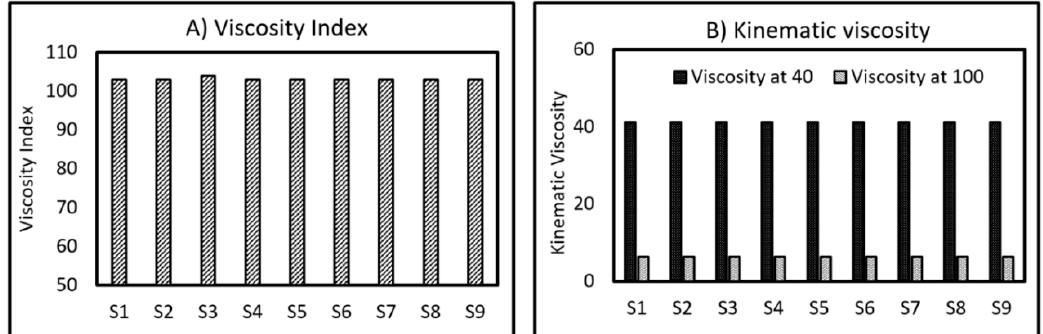
Figure 4. Viscosity index ( A ) and Kinematic viscosity ( B ) of liquid lubricants.